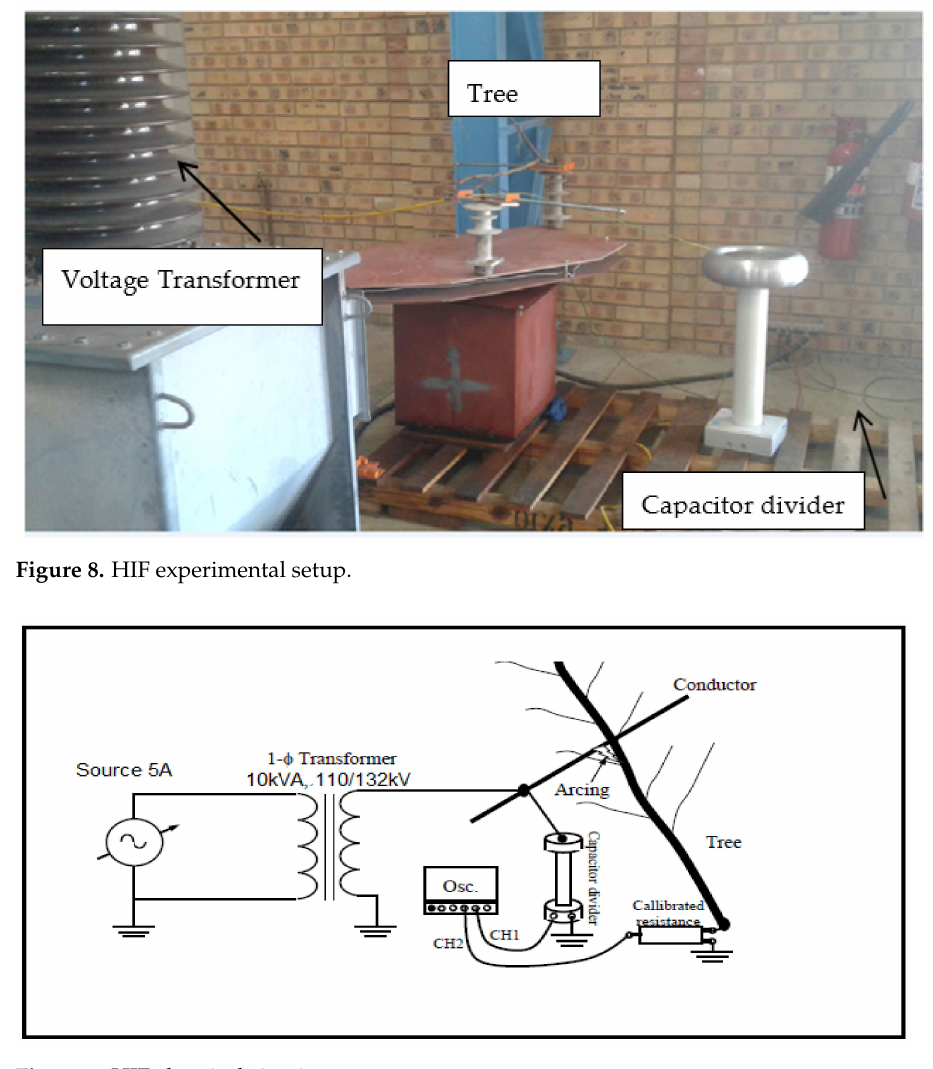
Figure 9. HIF electrical circuit.